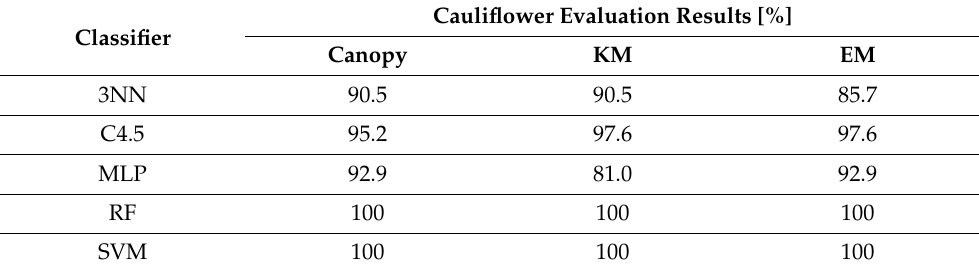
Table 14. The assessment of clusterization of the cauliflower